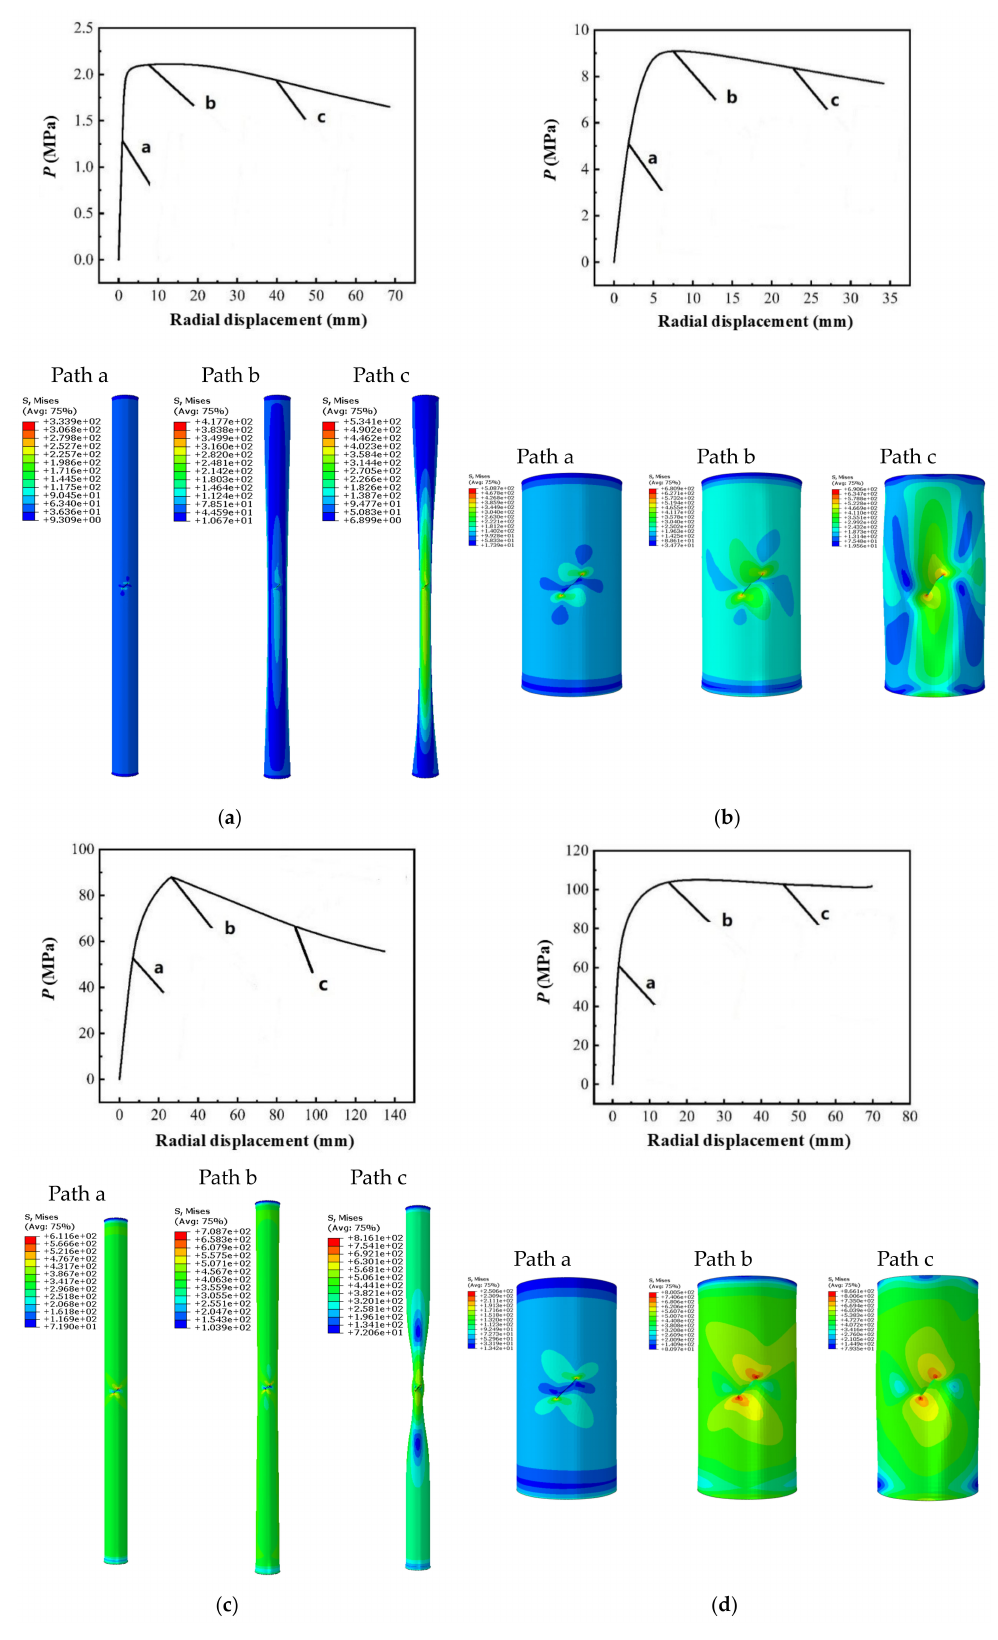
Figure 16. Buckling deformation diagrams of model 1–45~4–45(characteristics path) ( a ) Model 1–45; ( b ) Model 2–45; ( c ) Model 3–45; ( d ) Model